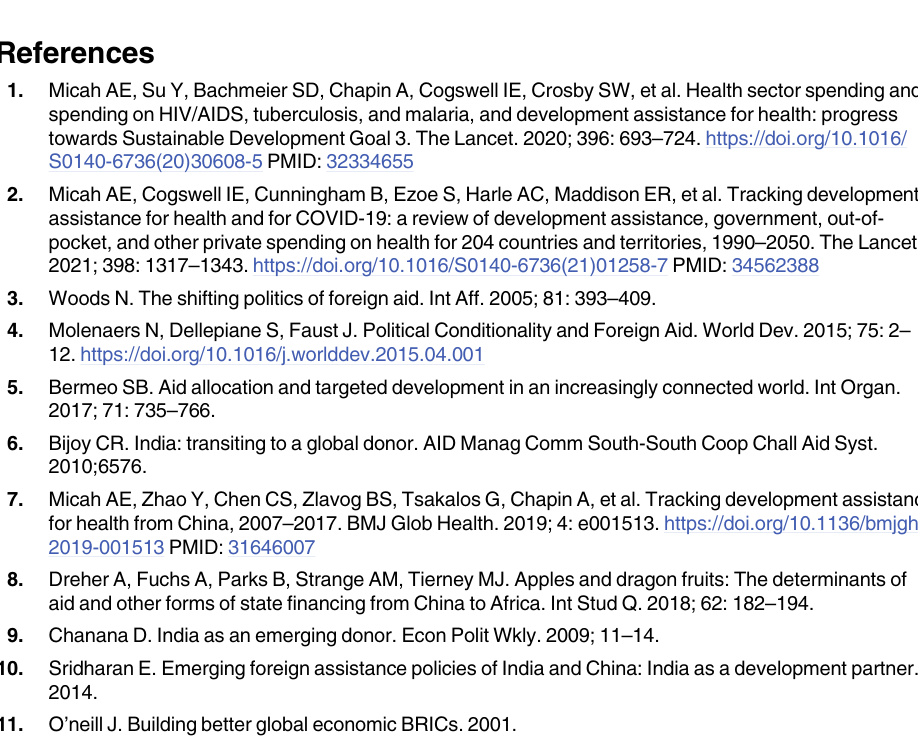
S1 Fig. DAH contributions by India to multilateral agencies, 2016–2019. (Note: Multilateral contributions shown here include both annual and replenishment